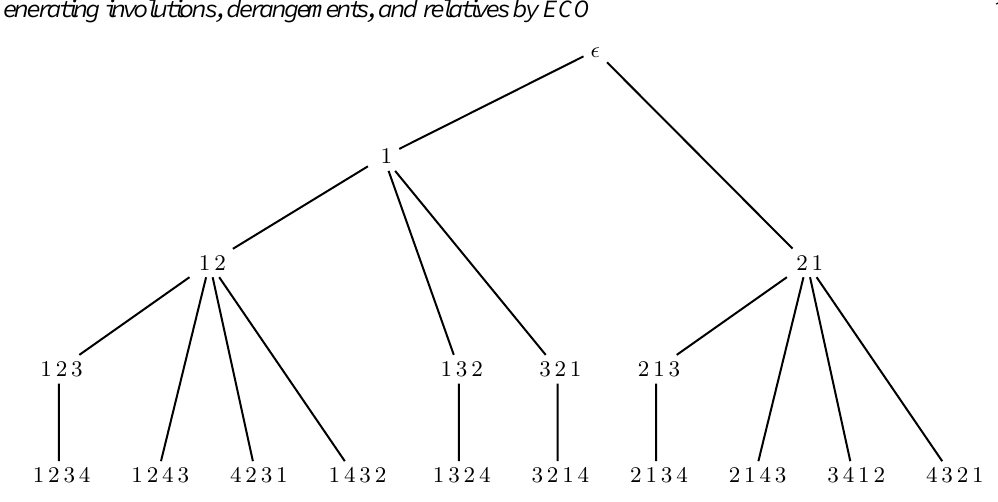
Fig. 4: The first five levels of the generating tree for involutions by recurrence.